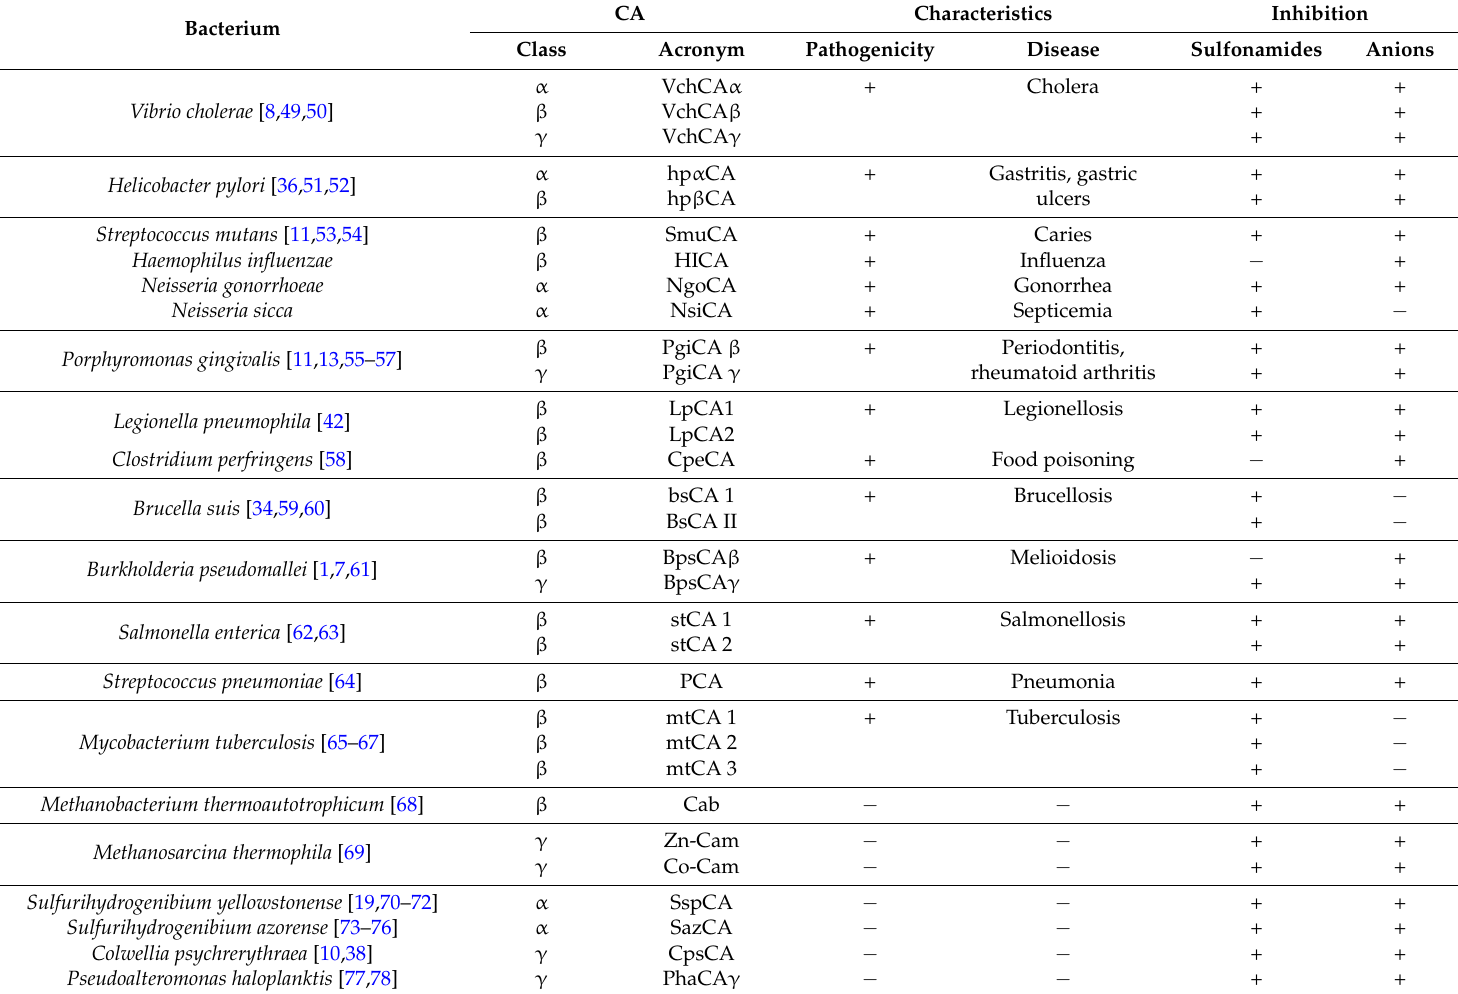
Table 1. Bacterial carbonic anhydrases (CAs) investigated by our groups for their biochemical properties, kinetic constants, and inhibition